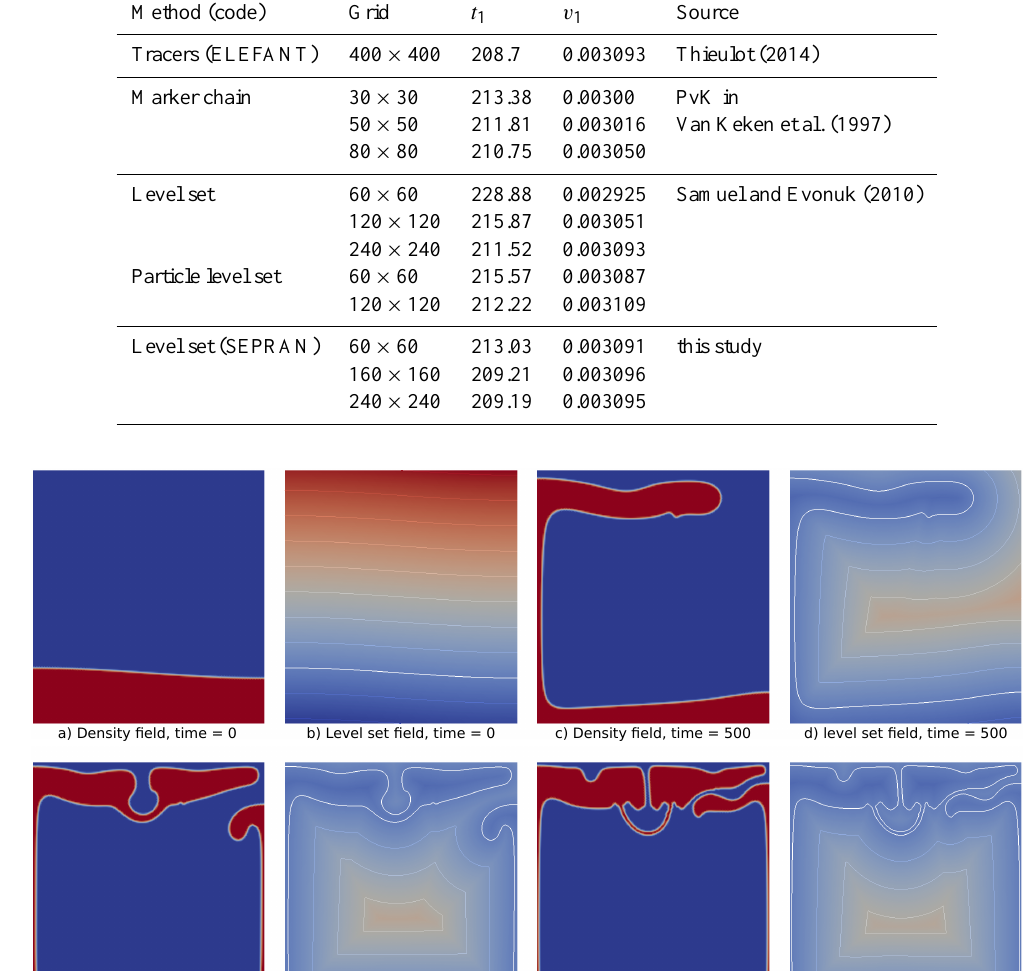
Table 1. Table containing the timing and hight (max v rms ) of the first peak of our model runs and selected others from the literature.